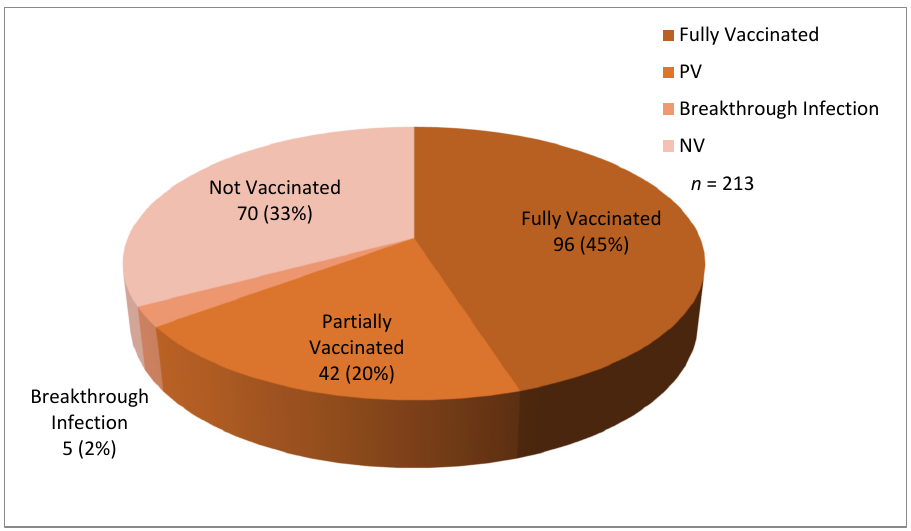
Figure 2. Vaccination status, breakthrough infection and timing of positive test result among 213 health care workers who tested positive for SARS-CoV-2, January 16 to 30 May 2021.